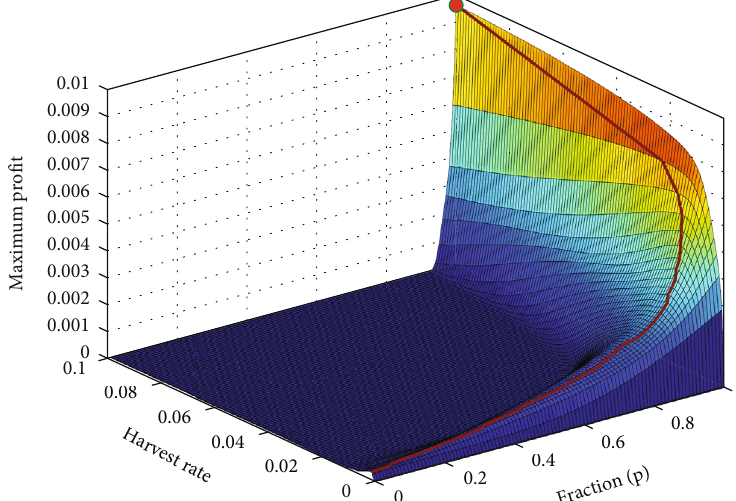
Figure 7: Simulation results, using system (18), including both African cat fi sh and Nile tilapia with proportional harvesting rates, i.e., ! = ðð 1 − p Þ h , ð 1 − p Þ h , ph , ph , ð 1 − p Þ h , ph Þ where 0 ≤ p ≤ 1 . The initial values are chosen positive, and other parameter values can be h p found in Tables 3 –